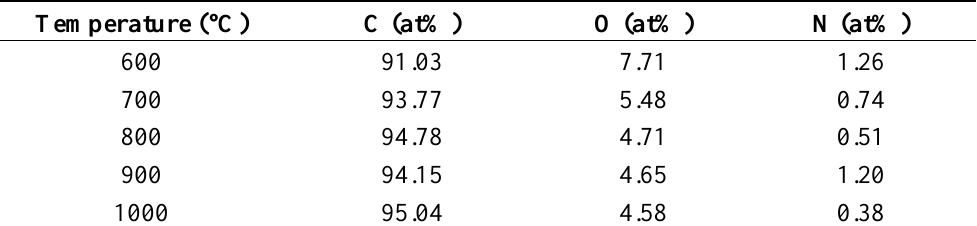
Table 2. C, O, N contents of CBCFs at various temperatures.